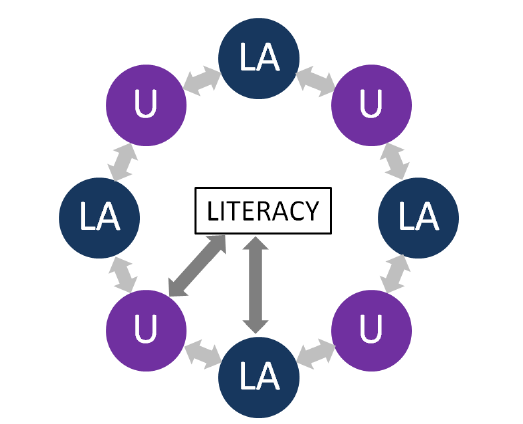
Figure 3. A grammar of participation. The diagram illustrates ongoing relational practices focused upon a matter of mutual concern such as the evaluation of pro- fessional development, understanding of partnership or literacy (LA = Local Au- thority U =